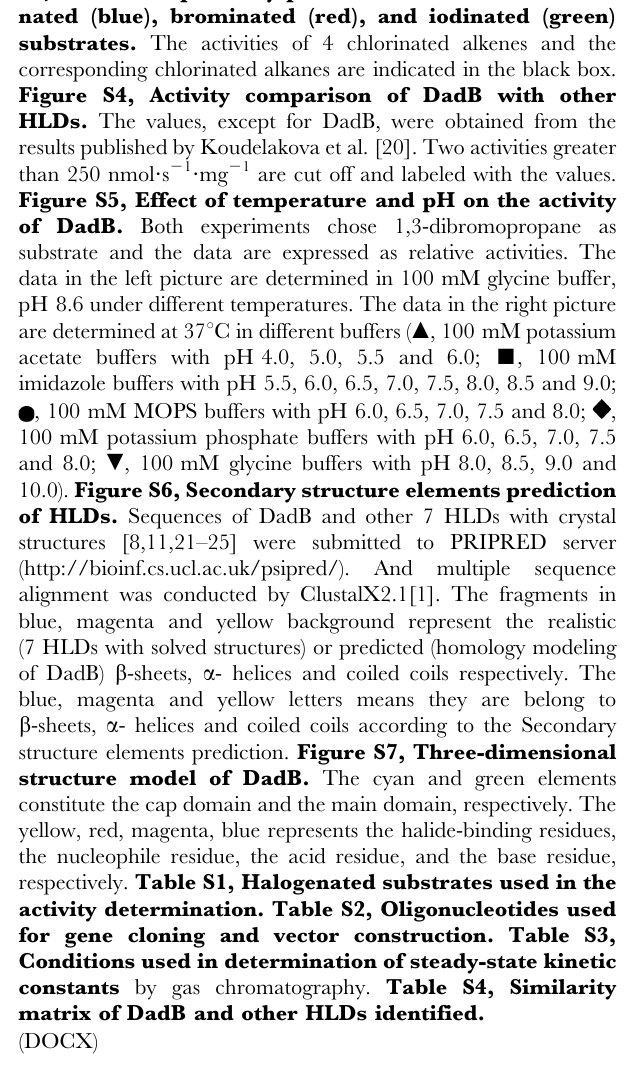
Figure S4, Activity comparison of DadB with other HLDs. The values, except for DadB, were obtained from the results published by Koudelakova et al. [20]. Two activities greater than 250 nmol ? s 2 1 ? mg 2 1 are cut off and labeled with the values. Figure S5, Effect of temperature and pH on the activity of DadB. Both experiments chose 1,3-dibromopropane as substrate and the data are expressed as relative activities. The data in the left picture are determined in 100 mM glycine buffer, pH 8.6 under different temperatures. The data in the right picture are determined at 37 u C in different buffers ( m , 100 mM potassium acetate buffers with pH 4.0, 5.0, 5.5 and 6.0; & , 100 mM imidazole buffers with pH 5.5, 6.0, 6.5, 7.0, 7.5, 8.0, 8.5 and 9.0;